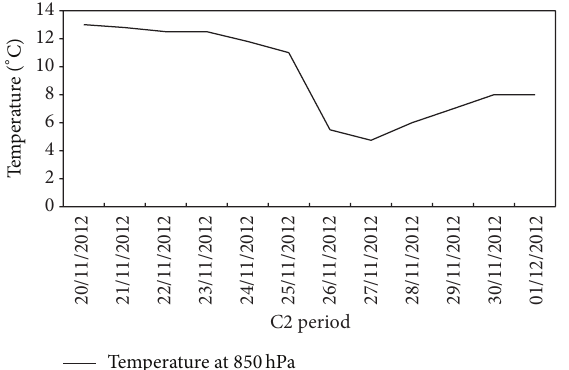
Figure 12: Temperature evolution at 850 hPa over Sfax in C2 period.